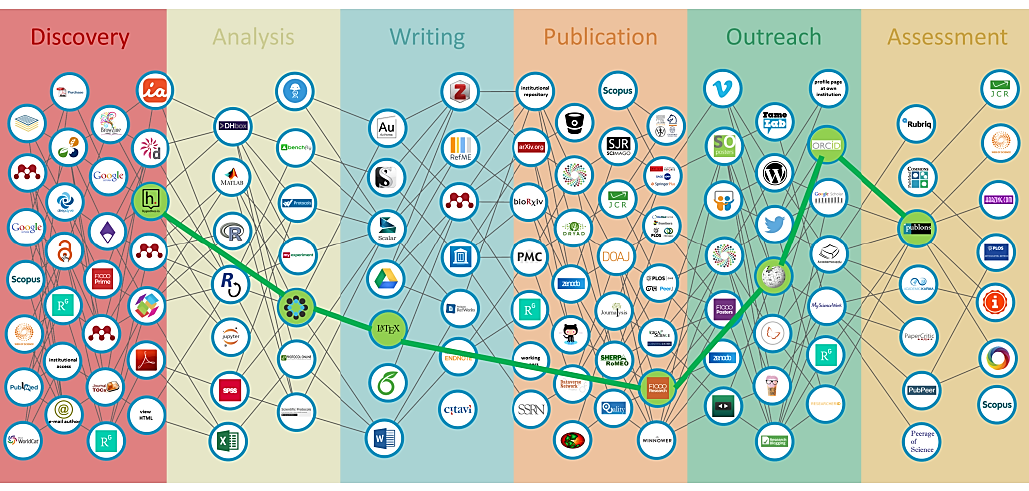
Figure 2: Digital tools used scientific communication (source: